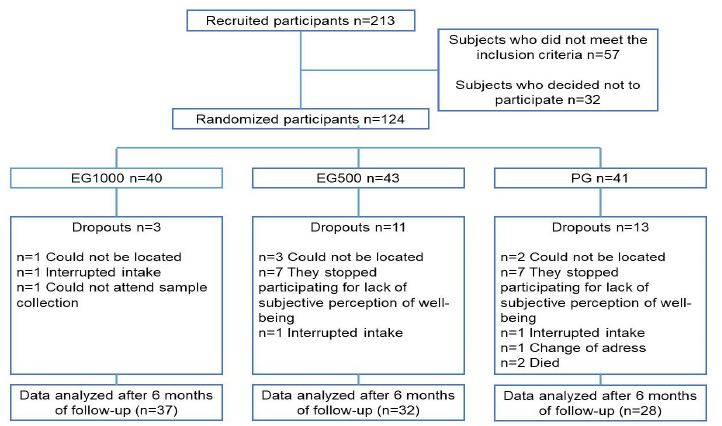
Figure 1. General study flowchart. Abbreviations: EG1000, group supplemented with 1000 mg/day of RV; EG500, group supplemented with 500 mg/day of RV; PG, placebo